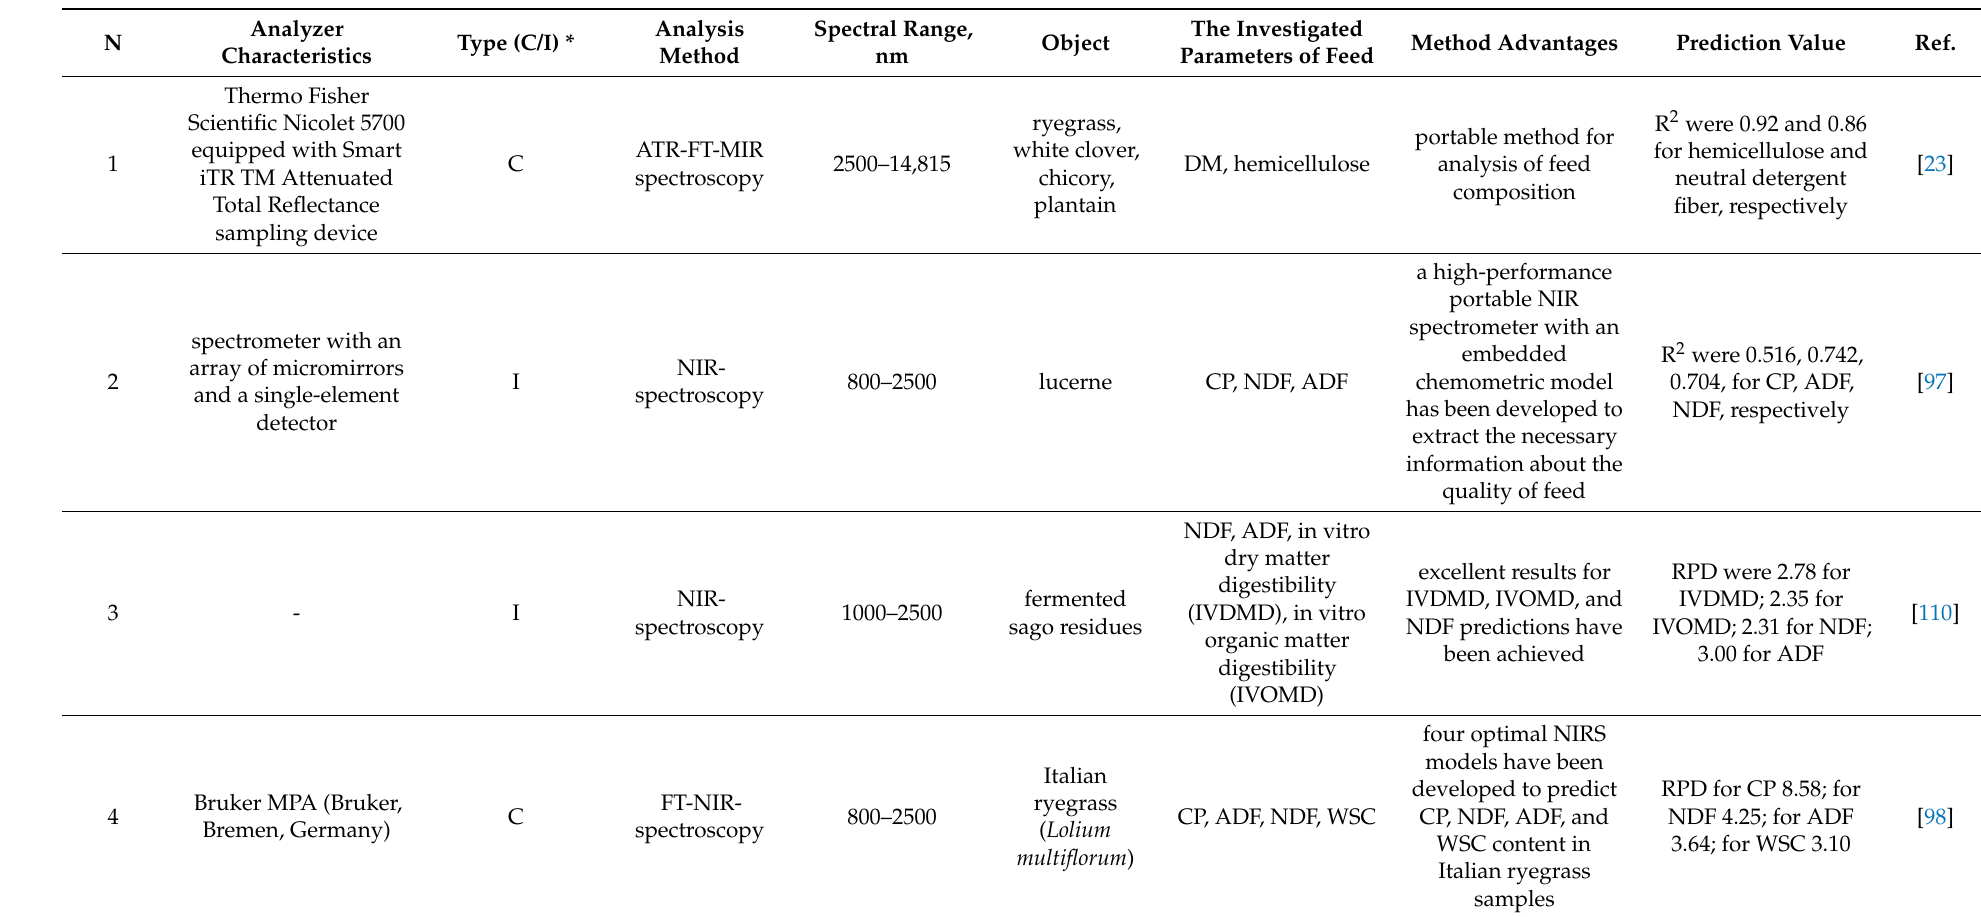
Table 3. Main characteristics of optical methods and devices used to assess the quality of